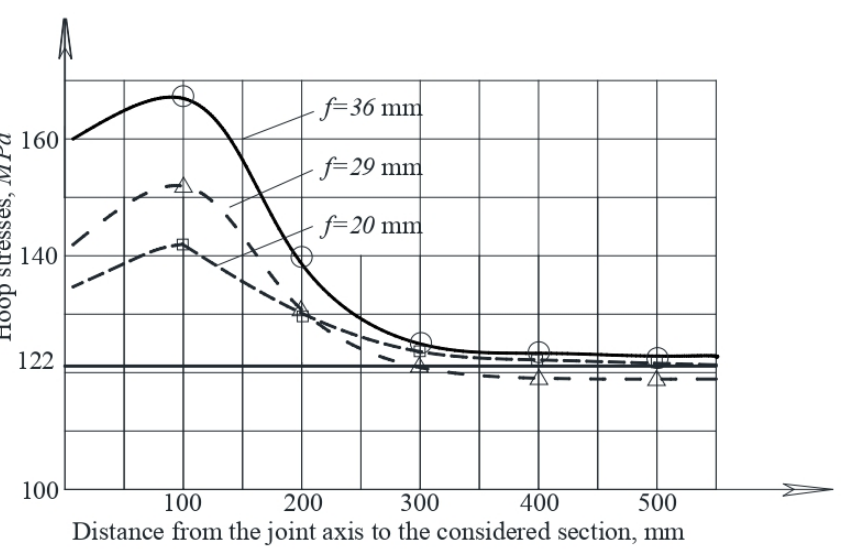
Figure 13. The meridional stress diagrams in the tank wall field joint zone with a volume of 3000 m 3 with bend: 我 f = 20 mm; 你 f = 29 mm; ○ f = 36 mm.